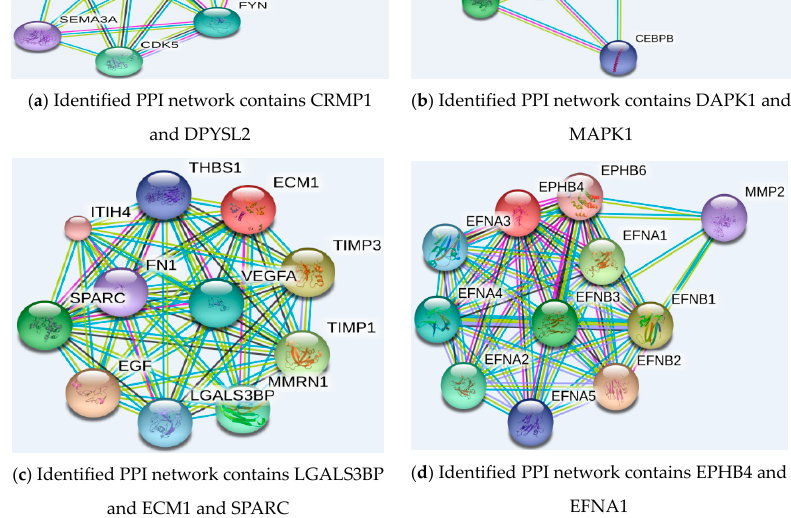
Table 6. Top 30 genes selected by MCFS.